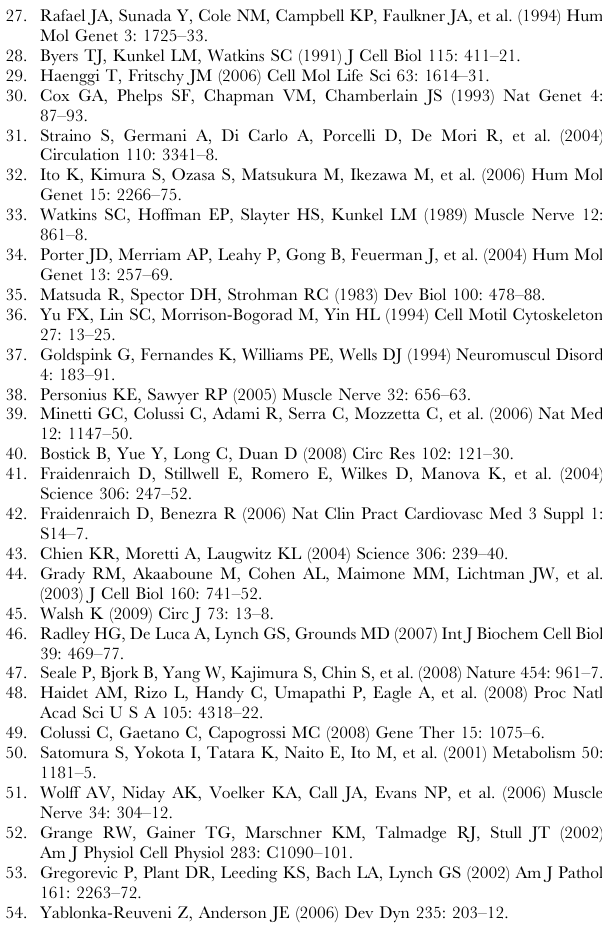
Table S5 Comparison of gene expression profiles between